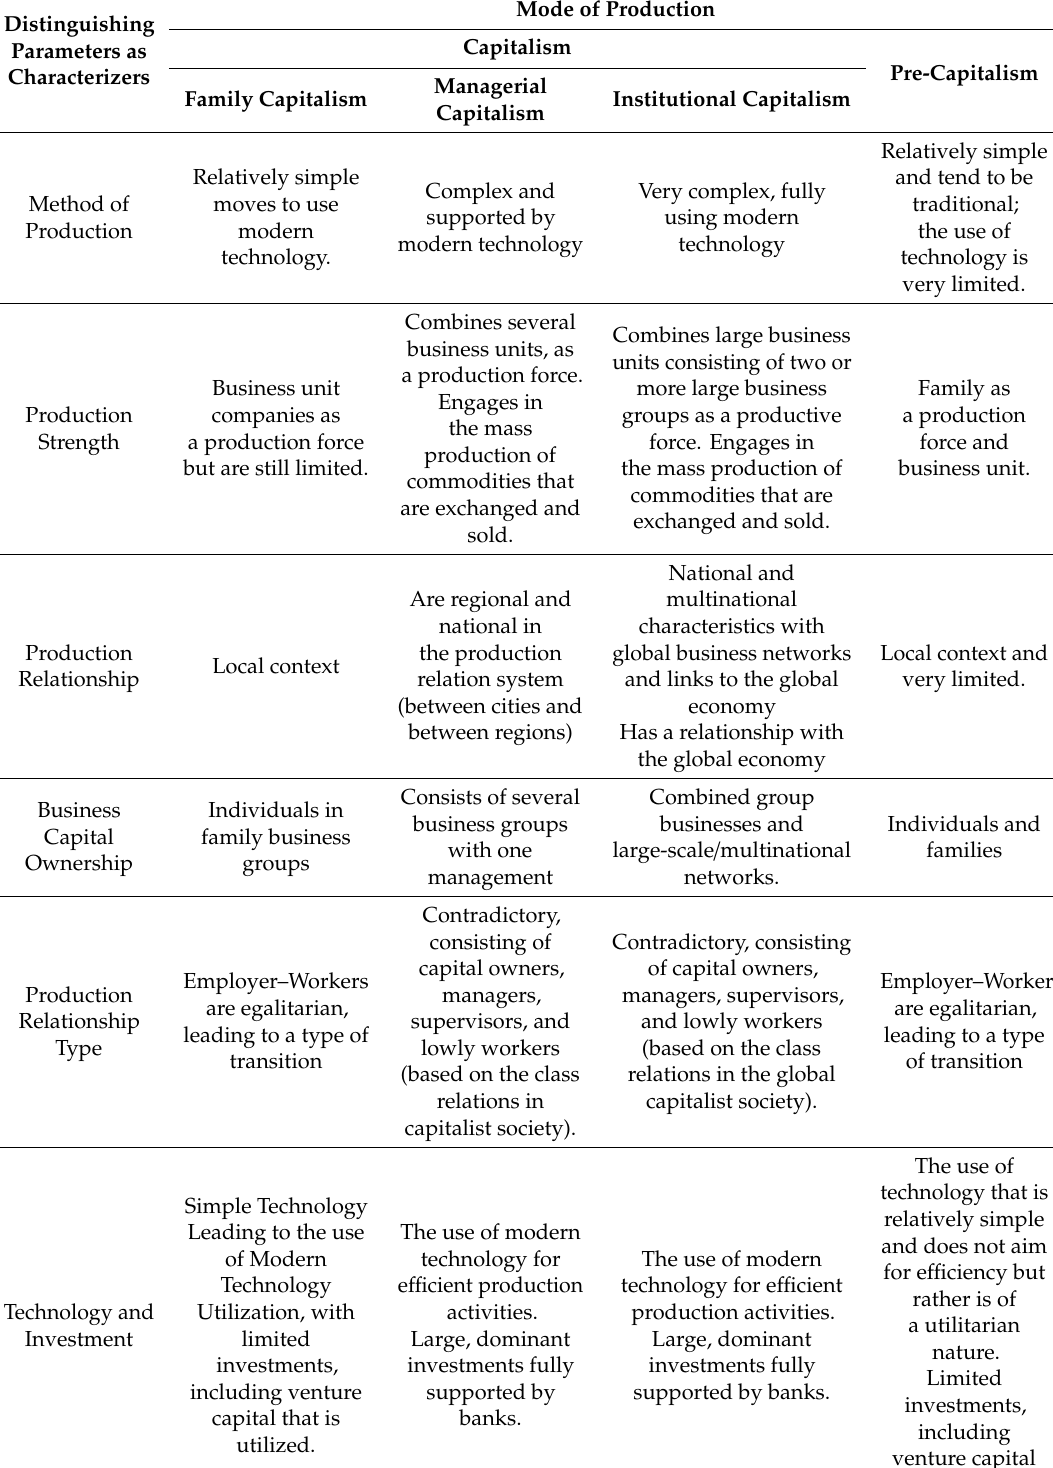
Table 3. Di ff erences in production procedures in new social